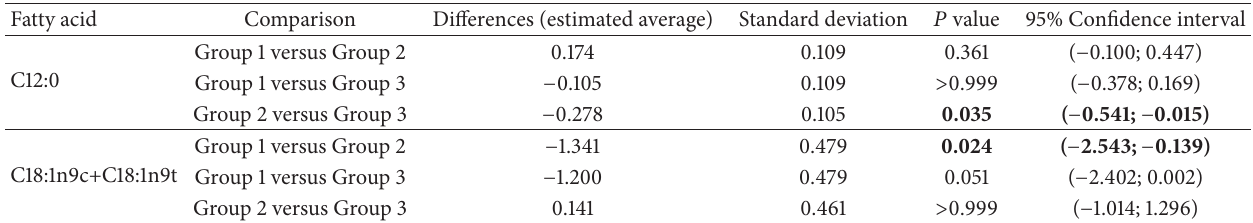
Table 5: Multiple comparison method for C12:0 and C18:1n9c+C18:1n9t based on